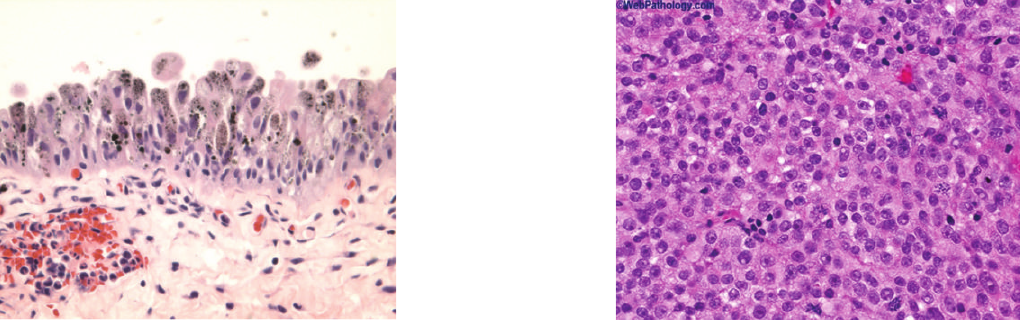
Figure 1: Haematoxylin and Eosin staining showing melanosis and not melanoma: this shows light brown powdery pigments to dark brown globules which are mainly present in the cytoplasm, partially or completely obscuring the nuclei. There is no evidence of any pigment deposit in the lamina propria. Taken from Jin et al. [52].